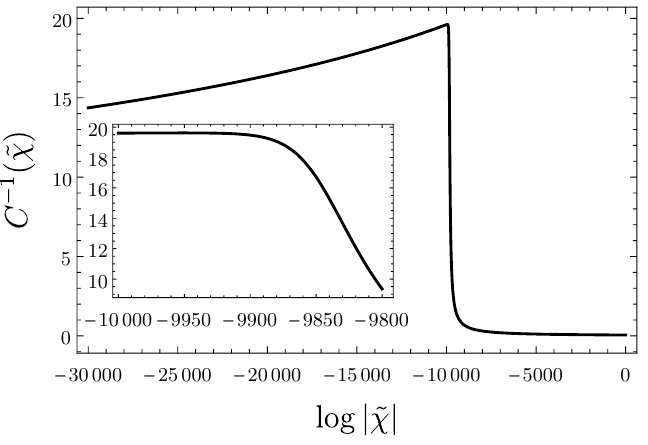
Figure 5 . Critical trajectory of C − 1 as functions of − τ = log | ˜ χ | in a wide range, for N S = 1 , N V = N F = 0 . We observe the very slow decrease of C − 1 to the fixed point value zero as ˜ χ → 0 . The inset demonstrates that the peak is